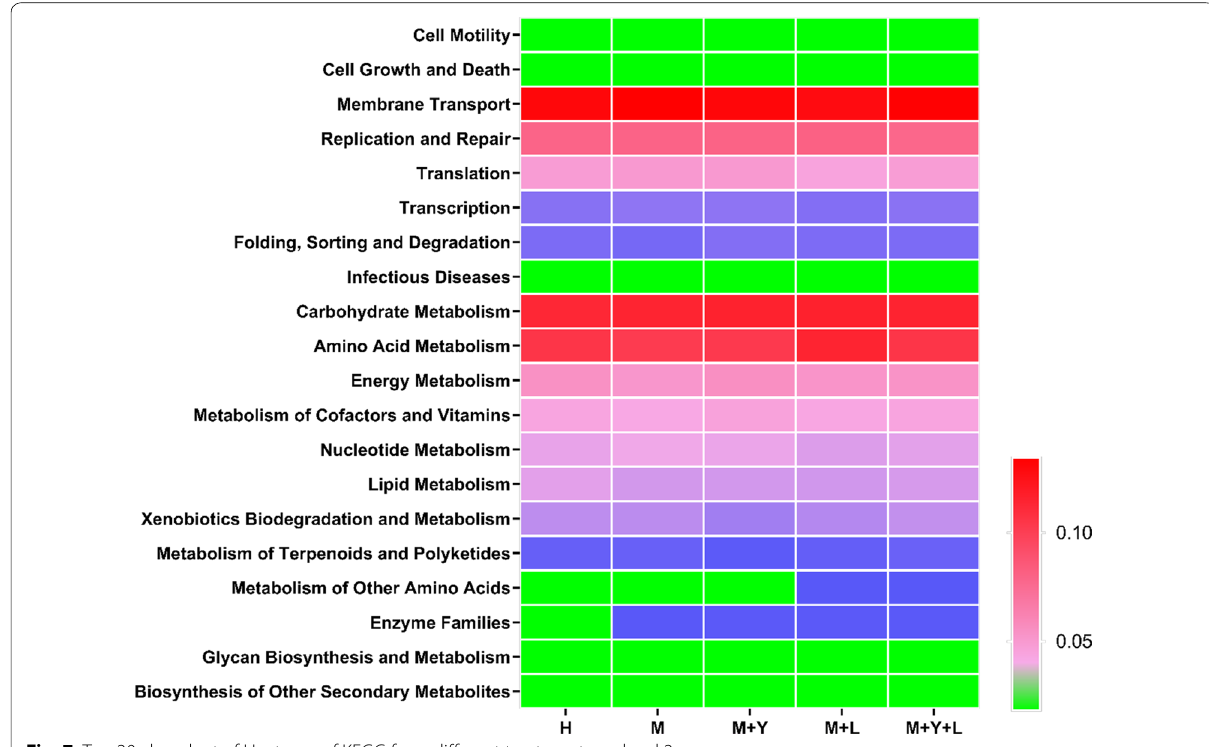
Fig. 7 Top 20 abundant of Heatmap of KEGG from different treatments on level 2